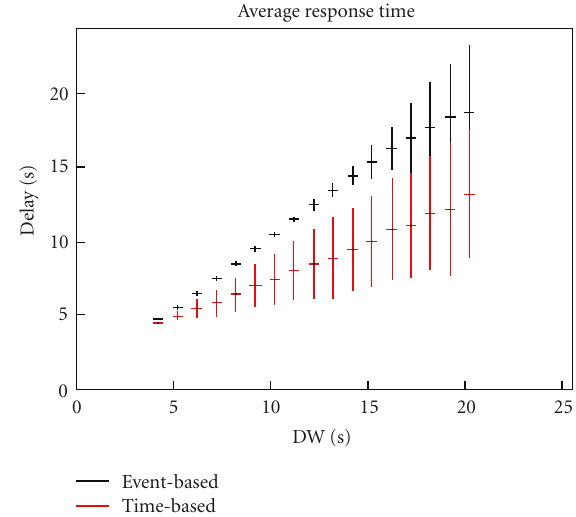
Figure 26: E ffi ciency behavior as a function of the DW width for the two DAQ models. The embedded plot is a reminder of vehicle IAT.